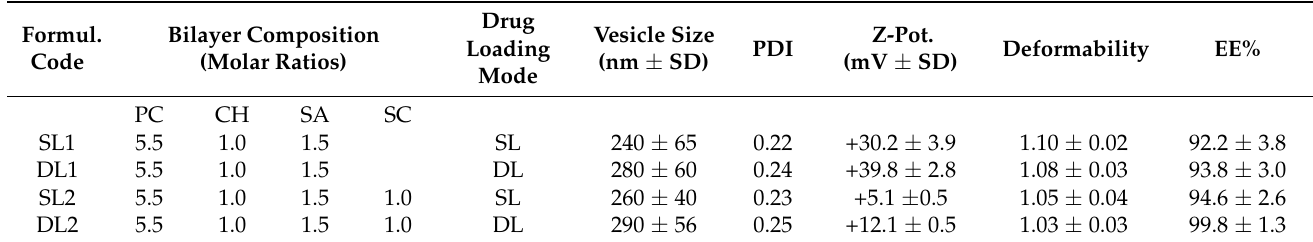
Table 3. Composition, particle size, polydispersity index (PDI), Z-potential, deformability and encapsulation efficiency (EE%) of butamben liposomes single-loaded (SL) with 1% w / v free drug in the lipid phase, or double-loaded (DL) with 0.5% w / v free drug in the lipid phase and 0.5% w / v in the aqueous phase as RAMEB complex.